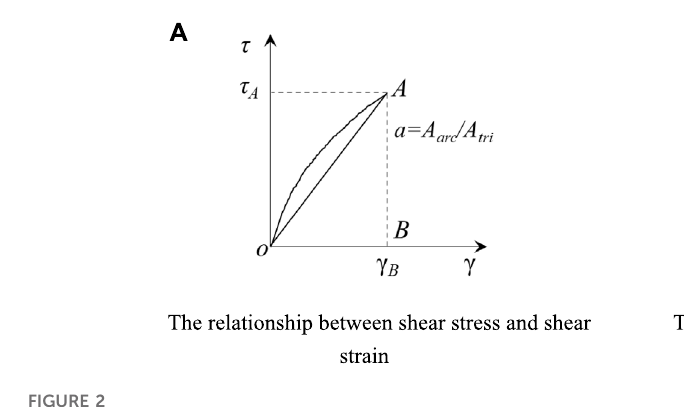
FIGURE 2 Physical meanings of parameters (A, B) .